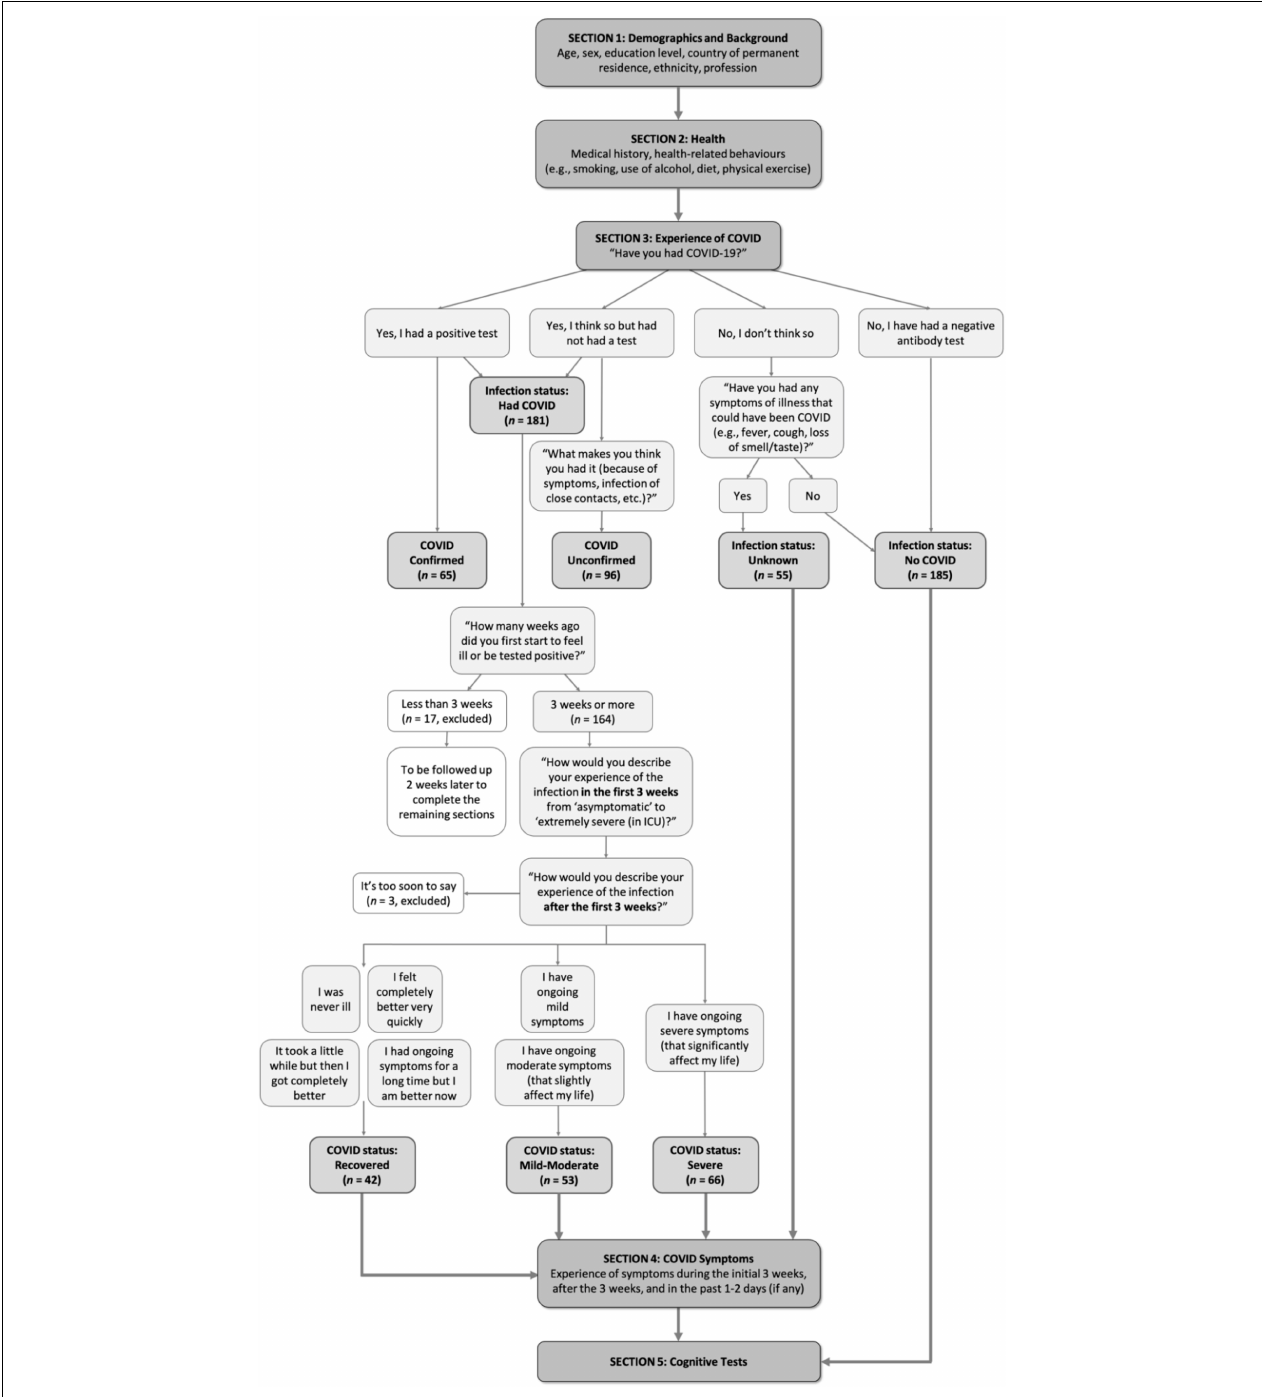
FIGURE 1 | Study procedural